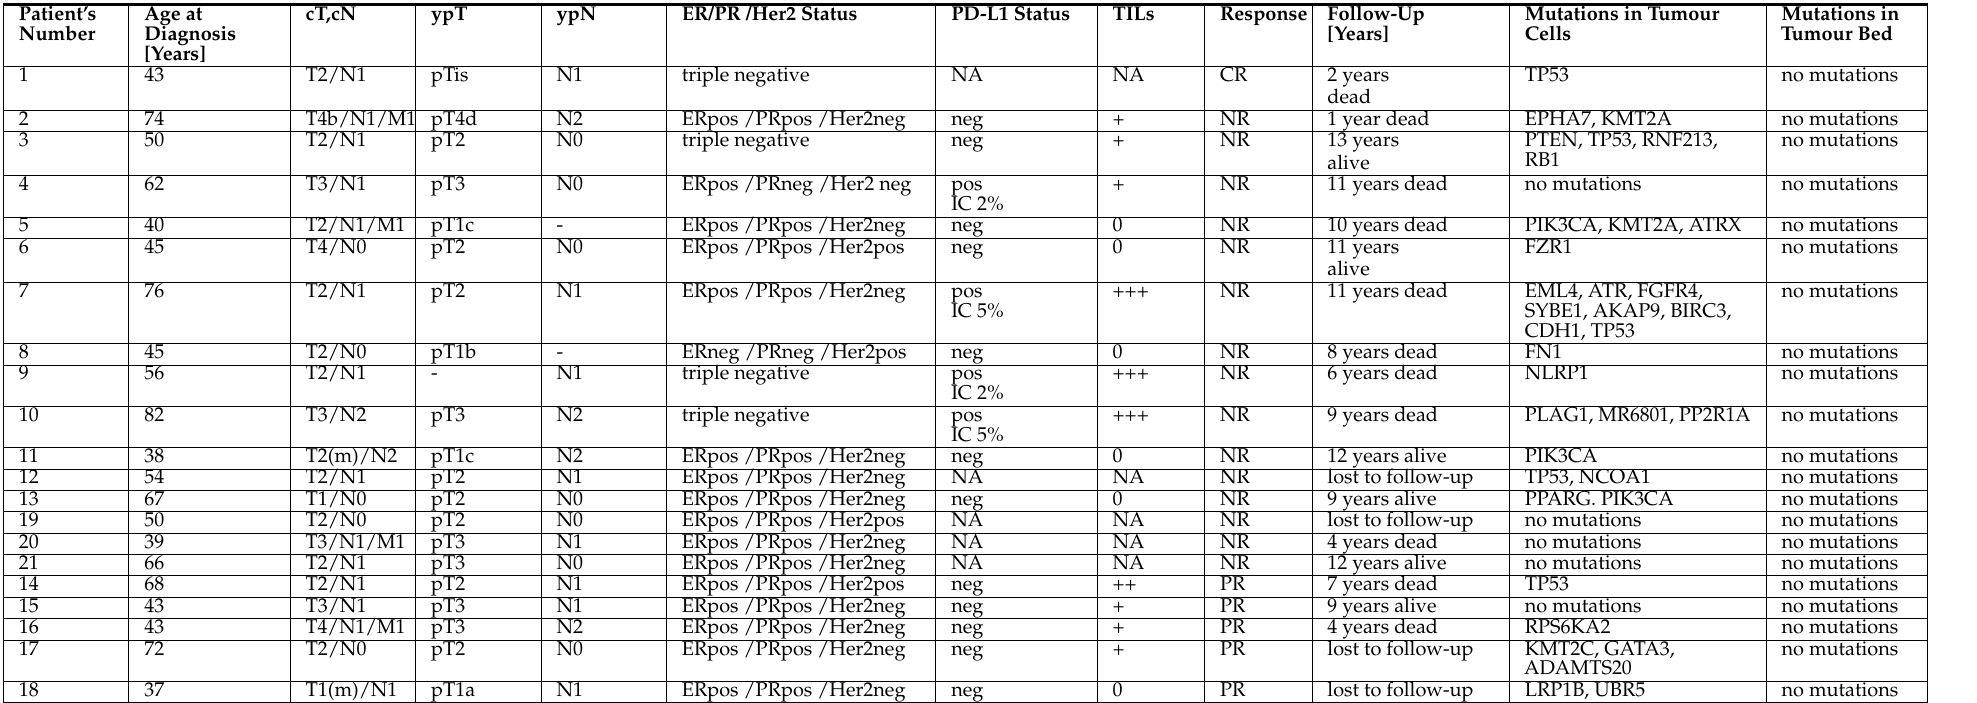
Table 1. Clinicopathological characteristics of the cohort along with the results of the next generation sequencing analyses. abbreviations: Response: CR Complete responder (only DCIS evidence in case 1), NR Non-responder, PR Partial responder, Status: ER Estrogen Receptor, PR: progesterone Receptor, TILs: tumor infiltrating